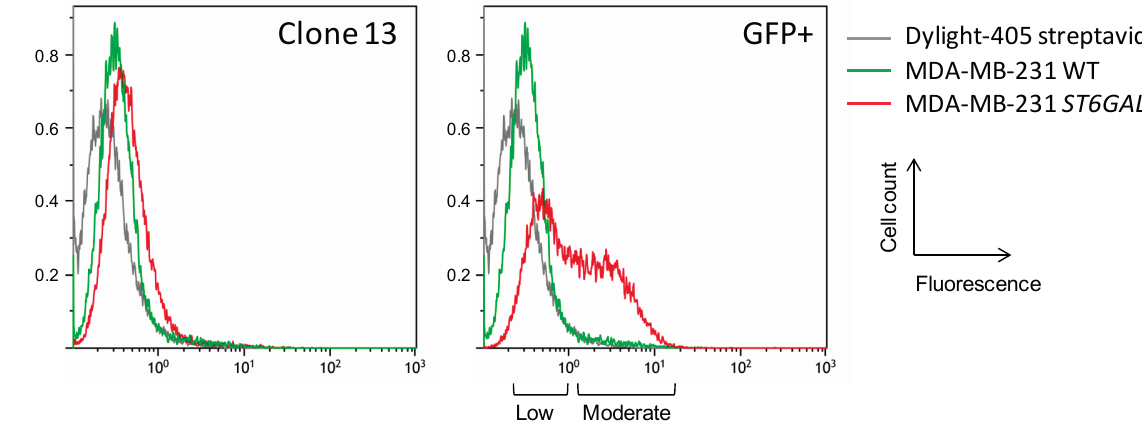
Figure 3. Flow cytometry analysis of α -2,6-sialylation in ST6GalNAc V transfected MDA-MB-231 cells. Detection of α -2,6-sialylation was performed using biotin-labeled SNA and revealed with Dylight-405-conjugated streptavidin. WT,